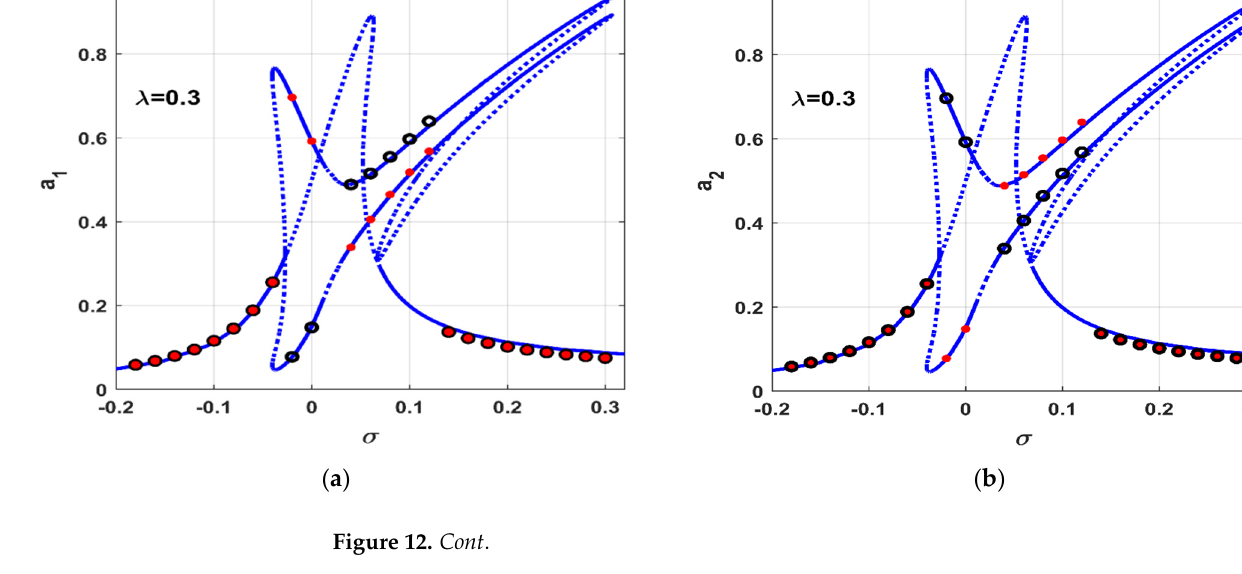
( d ) Figure 12. 𝜎 − response curve of the controlled Jeffcott rotor (i.e., 𝐸 = 0.03, 𝛿 (cid:2869) = 0.83 , and 𝛿 (cid:2870) = 0.002 ) at the negative and positive non-linear stiffness coefficient ( 𝜆 ): ( a , b ) oscillation amplitudes ( 𝑎 (cid:2869) and 𝑎 (cid:2870) ) versus 𝜎 when 𝜆 = 0.3 , and ( c , d ) oscillation amplitudes ( 𝑎 (cid:2869) and 𝑎 (cid:2870) ) versus 𝜎 when 𝜆 = −0.3 . The effect of the proportional gain 𝛿 (cid:2869) on the oscillatory motion of the Jeffcott system has been illustrated in Figure 13, where Figure 13a,b show the system oscillation ampli- tudes versus 𝜎 at 𝛿 (cid:2869) = 0.85 , while Figure 13c,d illustrate the vibration amplitudes at 𝛿 (cid:2869) = 0.8 . It is clear from the figure that the increase of 𝛿 (cid:2869) from 0.83 to 𝛿 (cid:2869) = 0.85 (See Figure 6c,d) has shifted the system response curves to the right as shown in Figure 13a,b, where the quasi-periodic motion that is reported in Figure 6c,d at 𝜎 = 0 , became a mono- stable periodic solution. However, Figure 13a,b confirm that the Jeffcott system may re- spond with an aperiodic motion (i.e., for example, at Ω = 1 + 𝜎, 𝜎 = 0.1 ). On the other hand, Figure 13c,d demonstrate the shift of the response curve to the left when 𝛿 (cid:2869) has been decreased from 0.83 (See Figure 6c,d) to 0.8 . Accordingly, the parameter 𝛿 (cid:2869) can be used as a control key to shifting the system response curves either to the right (i.e., via increasing 𝛿 (cid:2869) ) or to the left (i.e., via decreasing 𝛿 (cid:2869) ) in order to avoid the complex oscilla- tory behaviors of the controlled Jeffcott system at the resonance condition (i.e., when Ω ≅ 1 ). However, Figure 13 in general shows that the Jeffcott system response curve at 𝛿 (cid:2869) = 0.8 is better than the response curves when 𝛿 (cid:2869) = 0.83 and 𝛿 (cid:2869) = 0.85 .